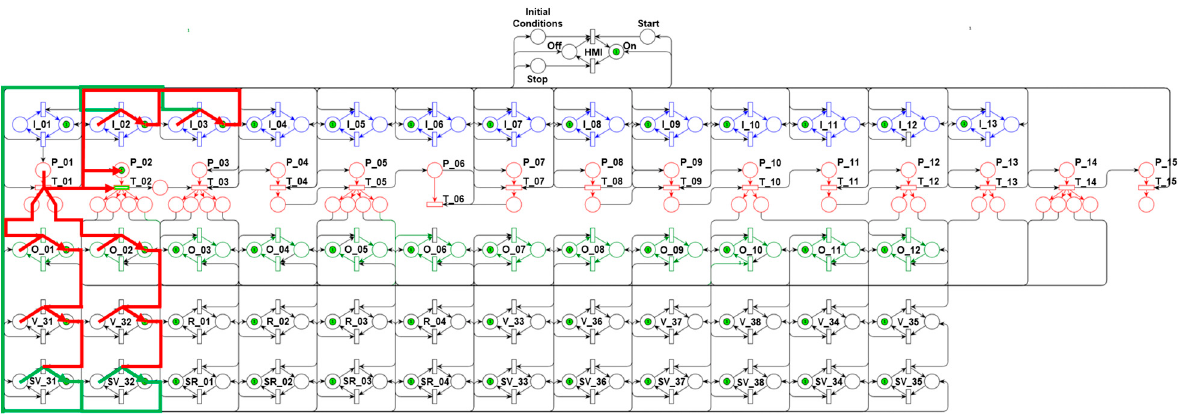
Figure 10. Algorithm’s second step—Open valves.